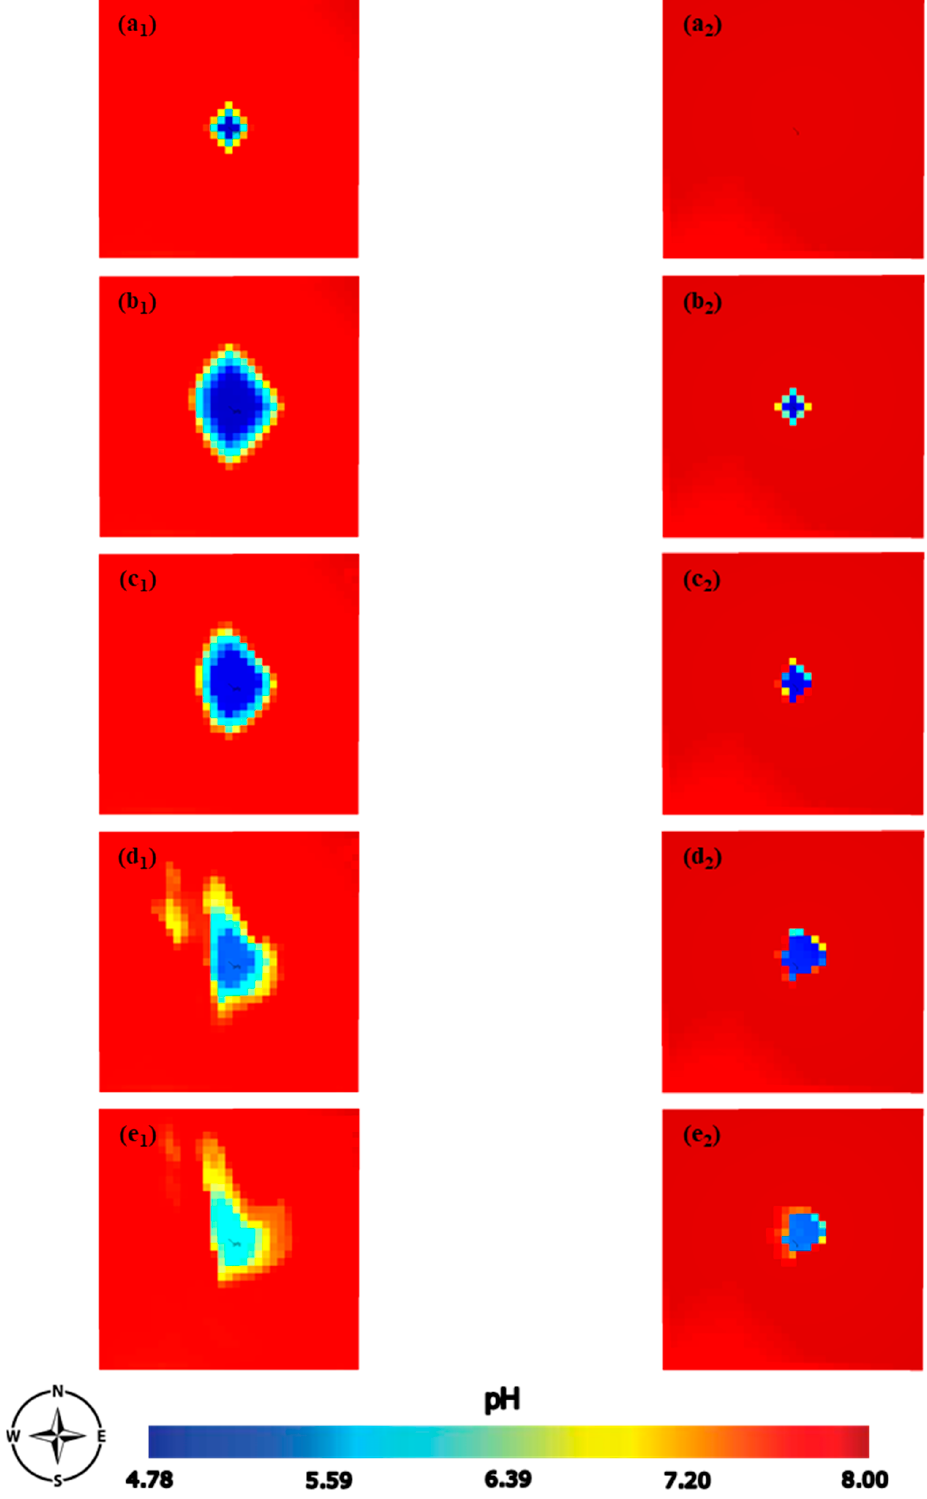
Figure A2. Plan view diagrams illustrating the simulated pH evolution for the base case from the arkosic layer top view ( a 1 , b 1 , c 1 , d 1 , e 1 ) and homogenous case from the Upper Mt. Simon top view ( a 2 , b 2 , c 2 , d 2 , e 2 ) at ( a ) 1 year, ( b ) 30 years, ( c ) 100 years, ( d ) 1000 years, and ( e ) 10,000 years. Each figure’s size is 35 km × 35 km (x, y).